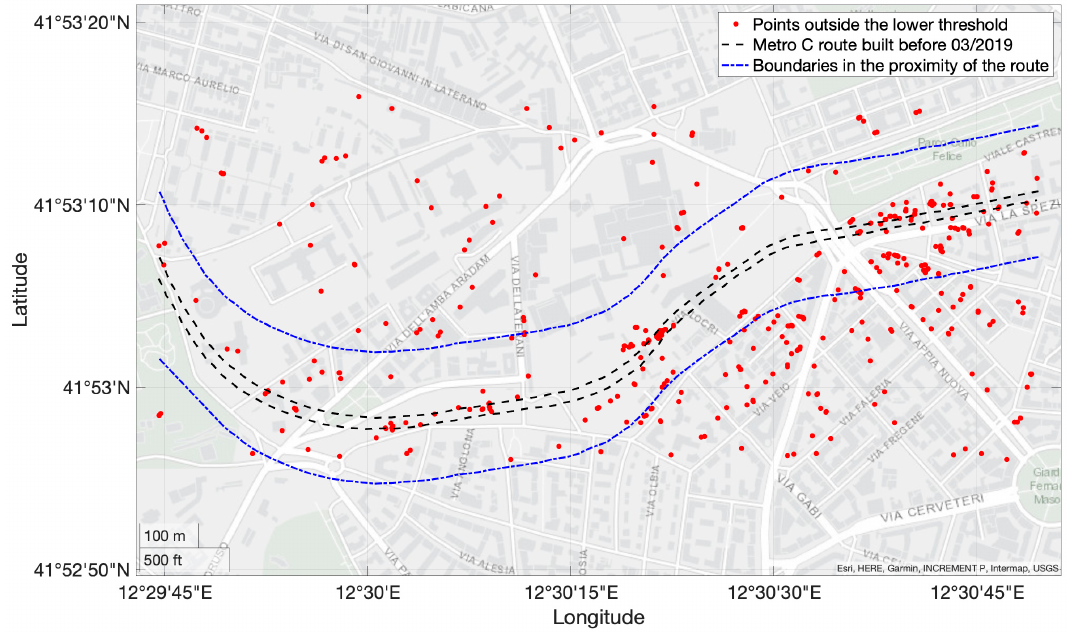
Figure 5. Map showing the points with velocity outside the imposed lower threshold, with respect to the subway route and the proximity boundaries.